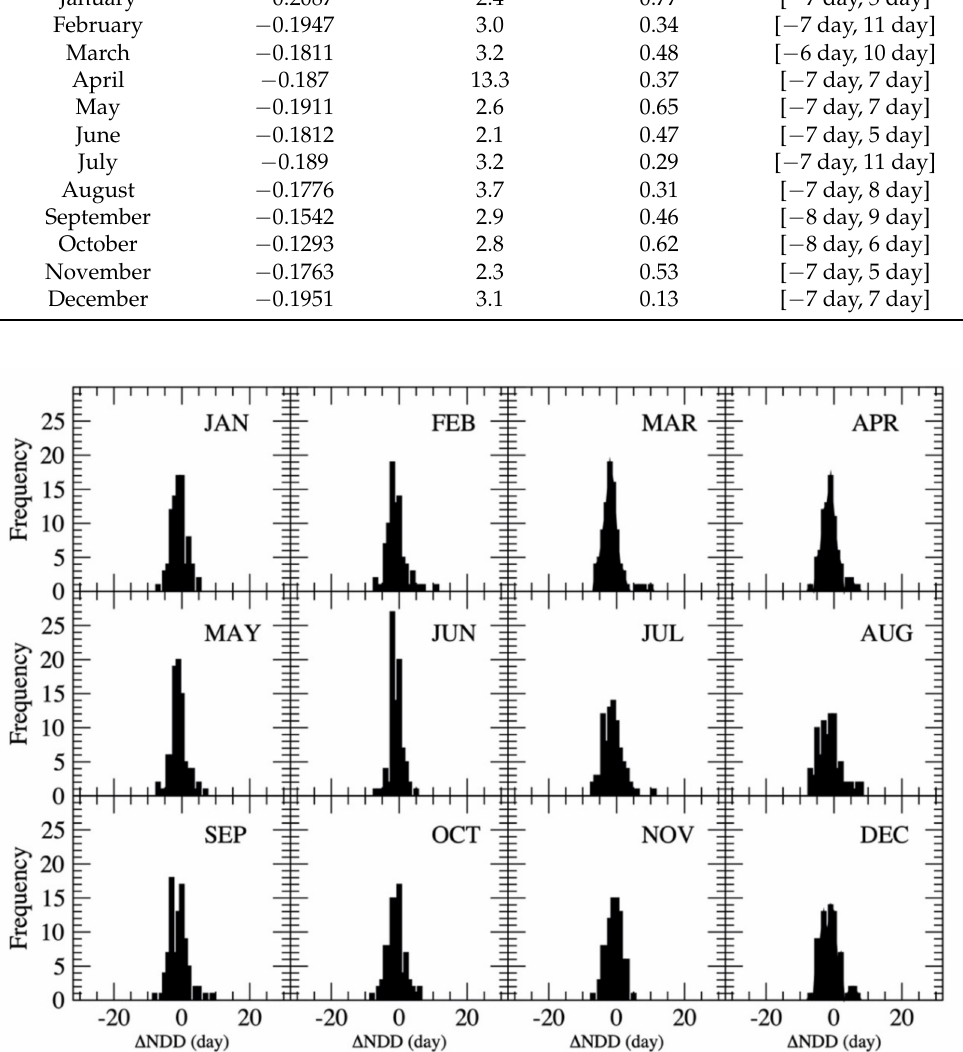
Figure 10. Probability distribution of each month’s ∆ NDD